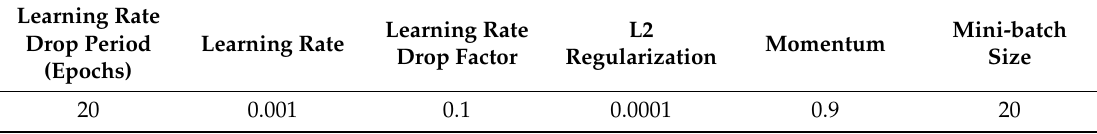
Table 5. Parameters used by our stochastic gradient descent (SGD) method.